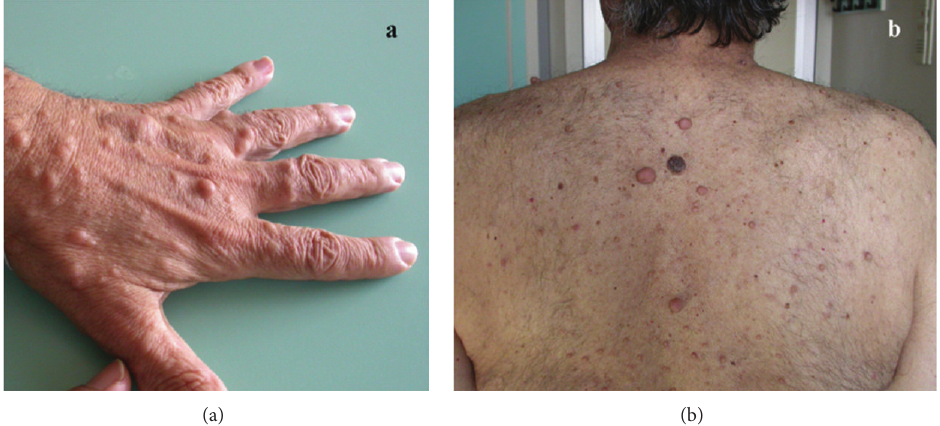
Figure 3: Cutaneous neurofibromas in patient affected by NF1 and duodenal GIST of the hand (a) and back